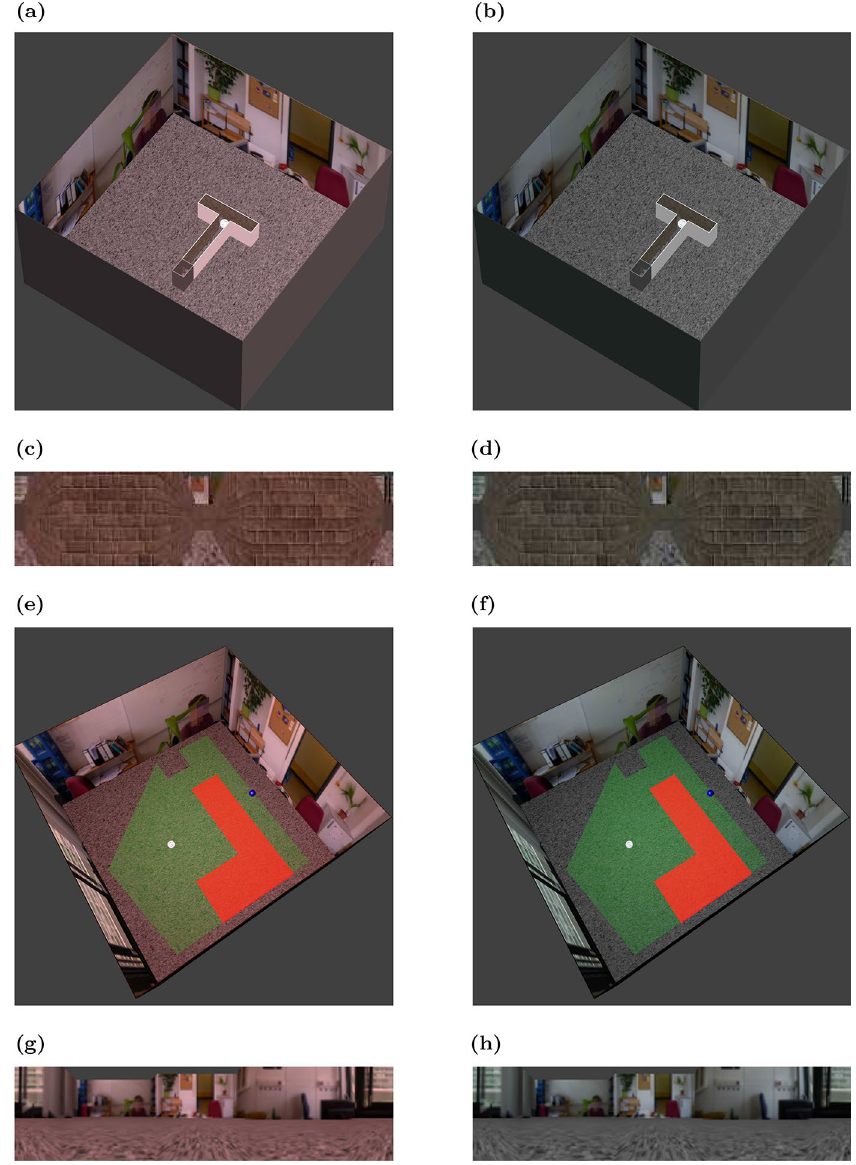
Figure 2. Examples of virtual environments and camera views. ( a , b ) Overview of T-maze in two different contexts. Two different contexts are generated by using different colors for the overall illumination. ( c , d ) Camera views in T-maze from the agent’s perspective. ( e , f ) Overview of shock zone maze used to study inhibitory avoidance. ( g , h ) Camera views in the shock zone